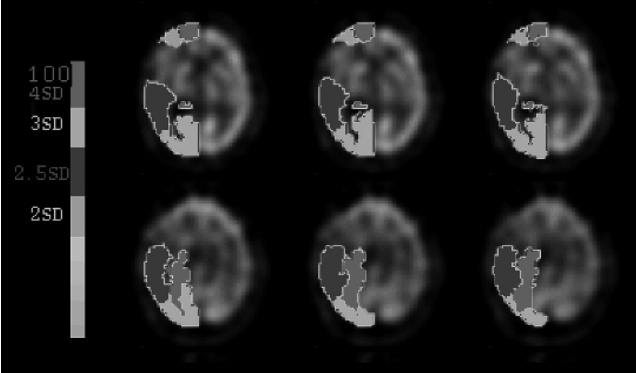
Fig. 2. Quantified Tc-99m-ethyl cysteinate dimmer SPECT performed 13 months post-onset revealing a relative cortical hypoperfusion in the fronto-temporo-parietal region associated with a marked aperfusion of the right